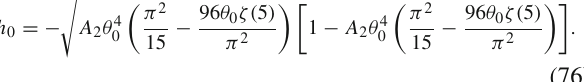
(dotted curve), A 2 = 3 × 10 7 (short dashed curve), A 2 = 4 × 10 7 (dashed curve), and A 2 = 5 × 10 7 (long dashed curve), respectively. The initial values used to numerically integrate Eqs. (71) and (72) are θ (τ ) = 0 . 009, while h 0 0 is obtained from Eq.